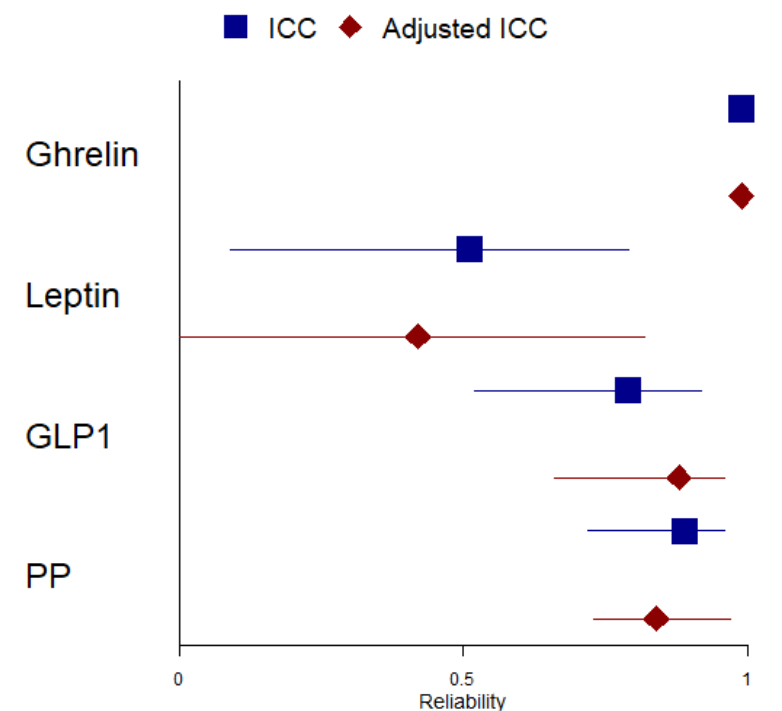
Figure 4. Forest plot depicting ICCs and adjusted ICCs with their respective 95% confidence intervals for all included GIHs.